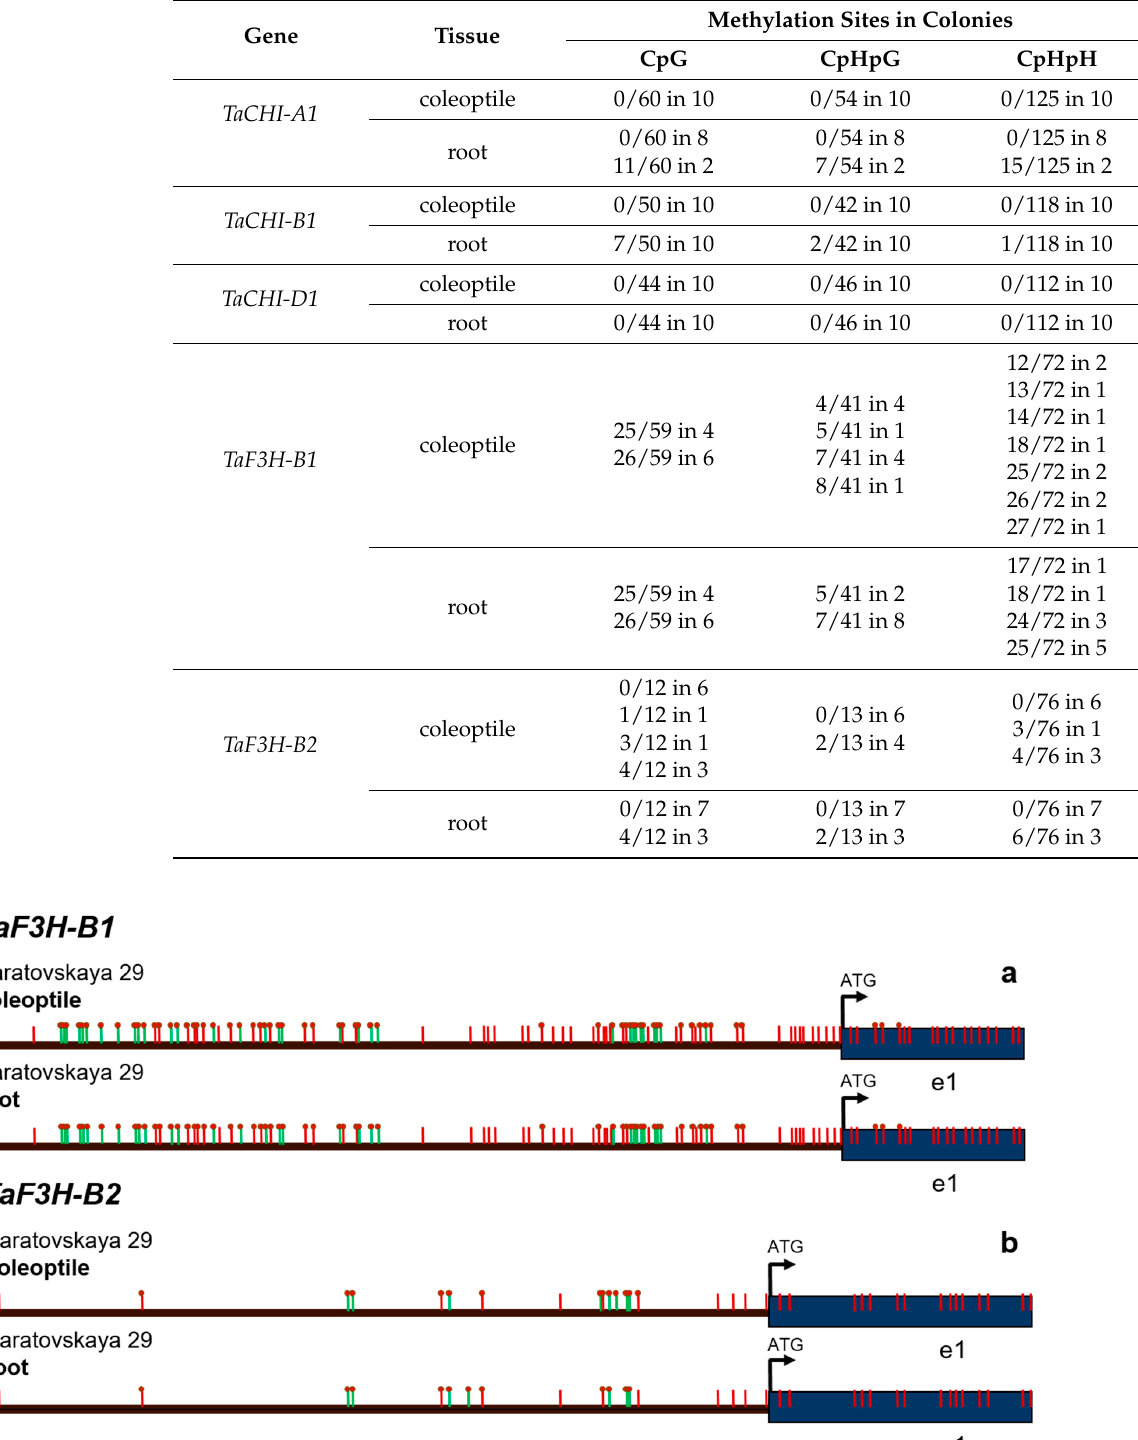
Table 2. The number of methylation sites in the TaCHI and TaF3H genes. The table shows the ratio of the number of the identified methylated sites to the total number of potential CpG, CpHpG, and CpHpH sites in the sequenced E. coli colonies.